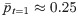
Coevolution of egalitarian social norm and resource management.Besides the evolution of norm, natural selection of resource management is implemented via the application of a pairwise comparison process to the individual resource management parameters Δi. The time scale τr of resource management evolution is either much larger than the time scale τn of norm evolution (i.e., s = 0.1, top rows) or the same as τn (i.e., s = 1, bottom rows). The population is initialized with Δi = 0. During the evolutionary process, there is some perturbation off in the updating process, which follows a uniform distribution ranging from −0.025 to 0.025. For reasonability of the coevolutionary model, we assume that the intensity of resource management performed by two parties (e.g., individual i and j) is in accordance with Δ = min(Δi, Δj). Note that it is the most unfavorable situation for the evolution of resource management. (a, h) Typical norm distribution of the initial state (a: p¯t=1≈0.25, q¯t=1≈0.25, e¯t=1≈0.667, c¯t=1≈0.73; h: p¯t=1≈0.249, q¯t=1≈0.252, e¯t=1≈0.664, c¯t=1≈0.73). (b, i) Probability distribution of resource management in the initial state (b: Δ¯t=1=0; i: Δ¯t=1=0). (c, d, e, j, k, l) Time evolution of five population variables. (f, m) Typical norm distribution of the stationary state (f: p¯t=20,000≈0.329, q¯t=20,000≈0.207, e¯t=20,000≈0.756, c¯t=20,000≈0.925; m: p¯t=20,000≈0.295, q¯t=20,000≈0.172, e¯t=20,000≈0.755, c¯t=20,000≈0.915). (g, n) Probability distribution of resource management in the stationary state (g: Δ¯t=20,000≈0.914; n: Δ¯t=20,000≈0.898). Note the logarithmic scale on x-axis in (c, d, e, j, k, l). All other model setups are the same as those used in Fig 1.